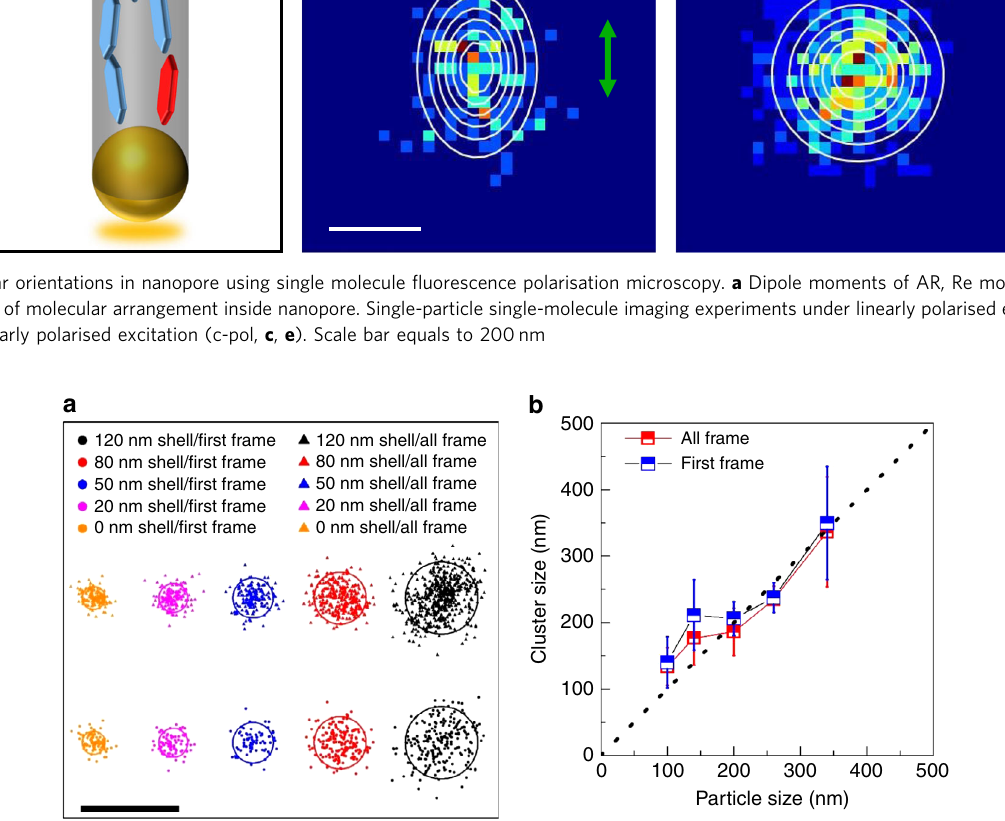
Fig. 3 Cluster analysis of Re positions with and without nanoporous shell. a Typical cluster distributions of molecular positions of Re when fi rst detected and during their whole life time (all frame) inside nanopore at different pore lengths. The solid line represents the overall average diameter of core – shell nanoparticles. b Cluster sizes (mean ± s.d.) from over 20 core – shell nanoparticles versus the overall diameter of core – shell nanoparticles. Scale bar equals to 500